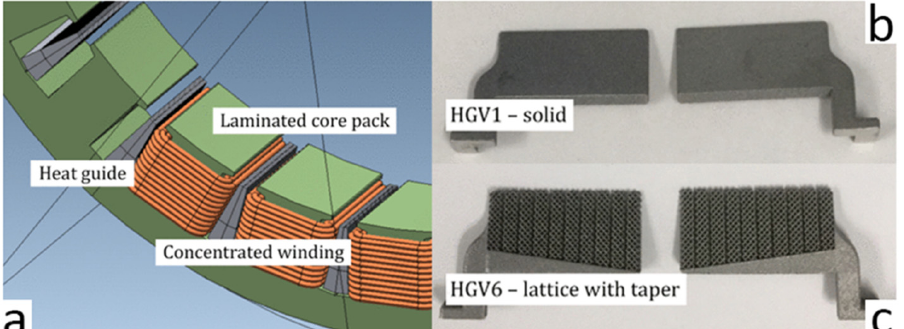
Figure 14. Additively manufactured heat guides places between the windings ( a ), a heat guide with a solid structure ( b ) and a heat guide utilizing a taper and a lattice structure to reduce eddy current losses ( c ) [92].